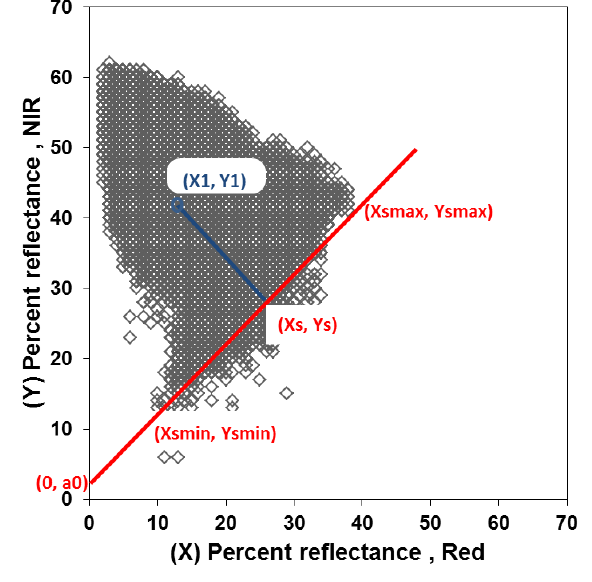
Figure 3. Typical scatter plot of image pixel reflectances in the red and near-infrared